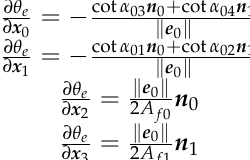
→ → x 1 x 0 and x 1 x 2 , α 04 represents the angle between f 0 , and A f 1 means the area of unit